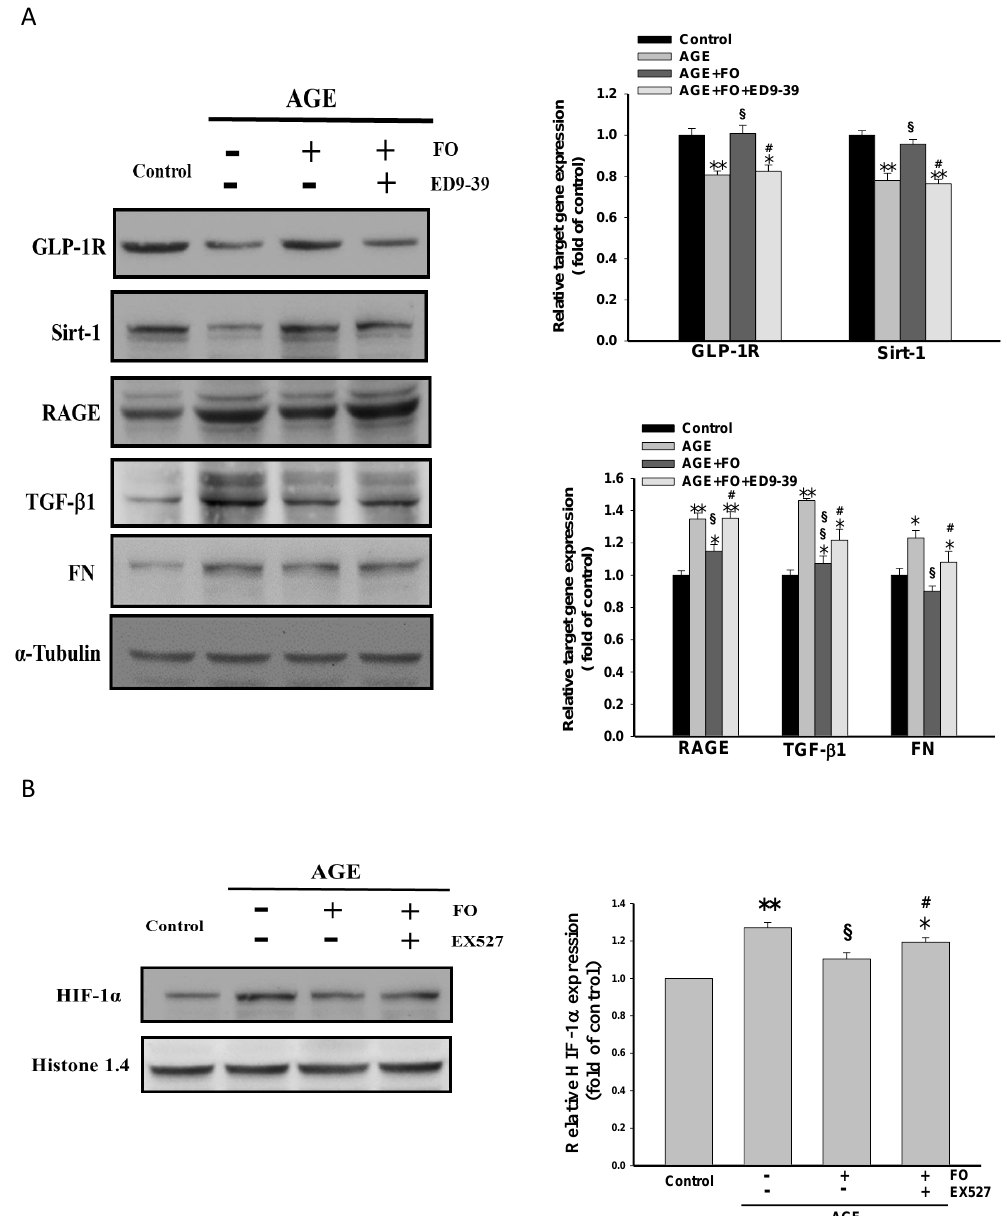
Figure 4. The e ff ects of exendin-3 (9-39) (ED9-39) on fucoidan-regulated target gene expression. The NRK-52E cells were incubated with AGE (100 µ g / mL) for 24 h followed by treatment with fucoidan (100 µ g / mL) for 24 h in the presence or absence of ED9-39 (1 mM). The protein expression of target genes ( A ), and the nuclear level of hypoxia-inducible factor-1 α (HIF-1 α ) ( B ), were determined in various groups. Results were expressed as the mean ± S.E.M ( n = 5). * p < 0.05, ** p < 0.01 vs. control group; § p < 0.05, §§ p < 0.01 vs. AGE-treated alone cells; # P < 0.05 vs. AGE and fucoidan-treated